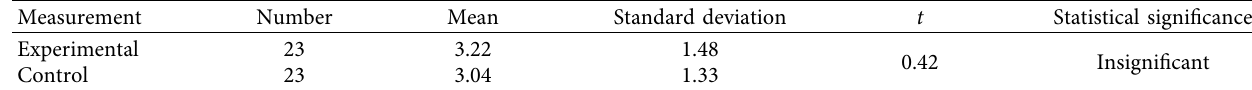
Table 4: The results of the t -test and the significance of the differences for the postmeasurement of the two groups, the experimental and the control, in the reading comprehension skills test at the level of direct comprehension.